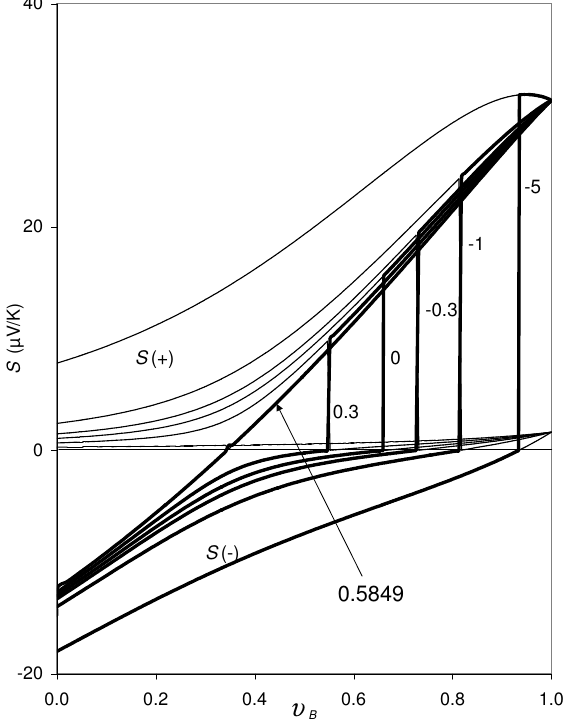
Figure 4. Same as Figure 2, for varying values of ∂ E C , A / ∂ T : ∂ E C , A / ∂ T = − 5 , − 1, − 0.3, 0, 0.3, and 0.5849 (in units of 10 − 6 eV/K), while ∂ E V , B / ∂ T = 0 and ∂ϕ i / ∂ n i = 0 is set. The discontinuity in the curves shifts to lower υ B as ∂ E C , A / ∂ T increases. For ∂ E C , A / ∂ T > 0.5849, Equation (9) does not have real solutions for the entire concentration range. For ∂ E C , A / ∂ T < 0.5849, the lower kink of S ( ± ) at the discontinuity occurs at S ( − ) = S (+) = 0,